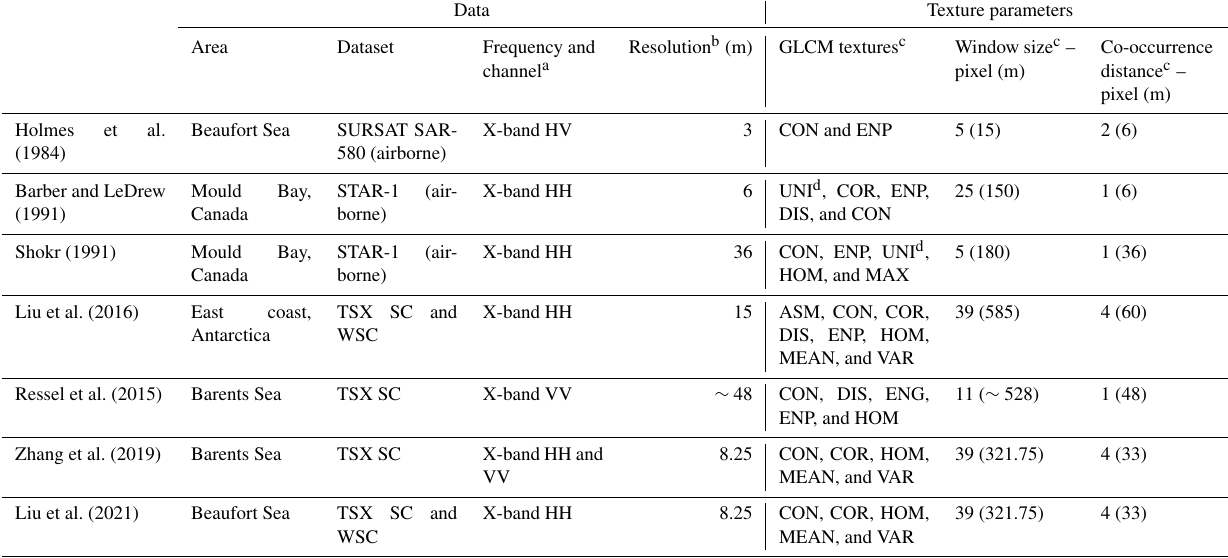
Table 1. Texture parameter selection in previous studies of X-band synthetic aperture radar (SAR) sea ice